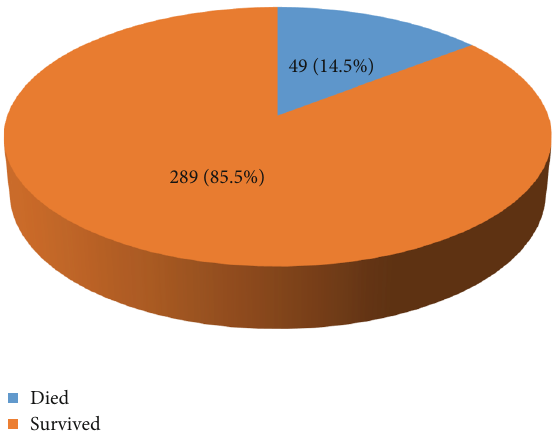
Figure 1: Mortality of children admitted with SAM at Jinja Regional Referral